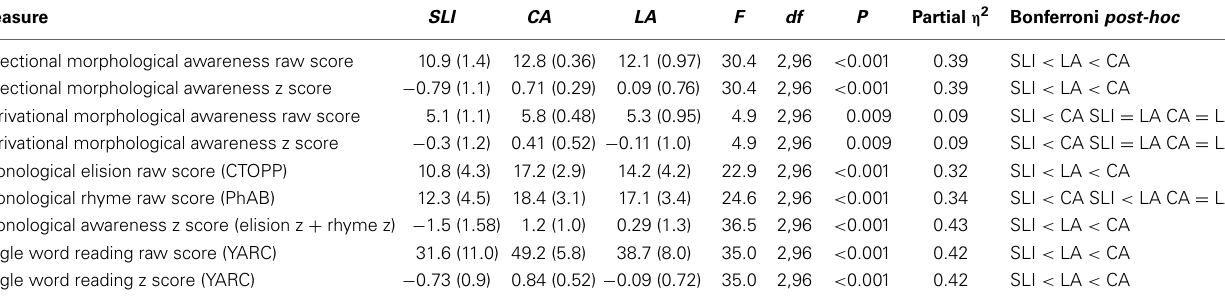
Table 2 | Means, standard deviations, f score, df, p -value, effect size and Bonferroni post-hoc results for language and literacy measures per group: SLI, CA,